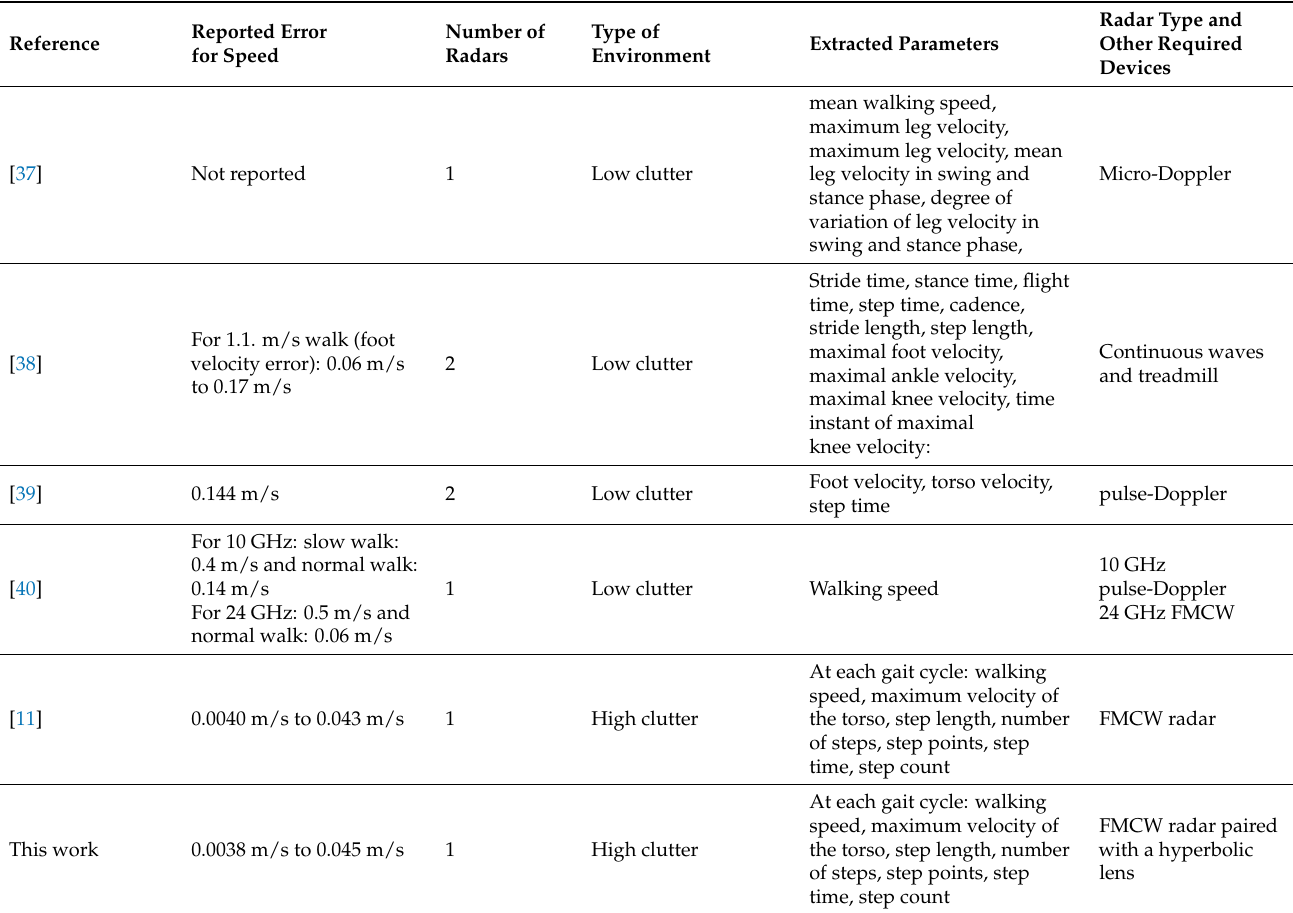
Table 3. Comparison of the gait results obtained in this paper with other previous